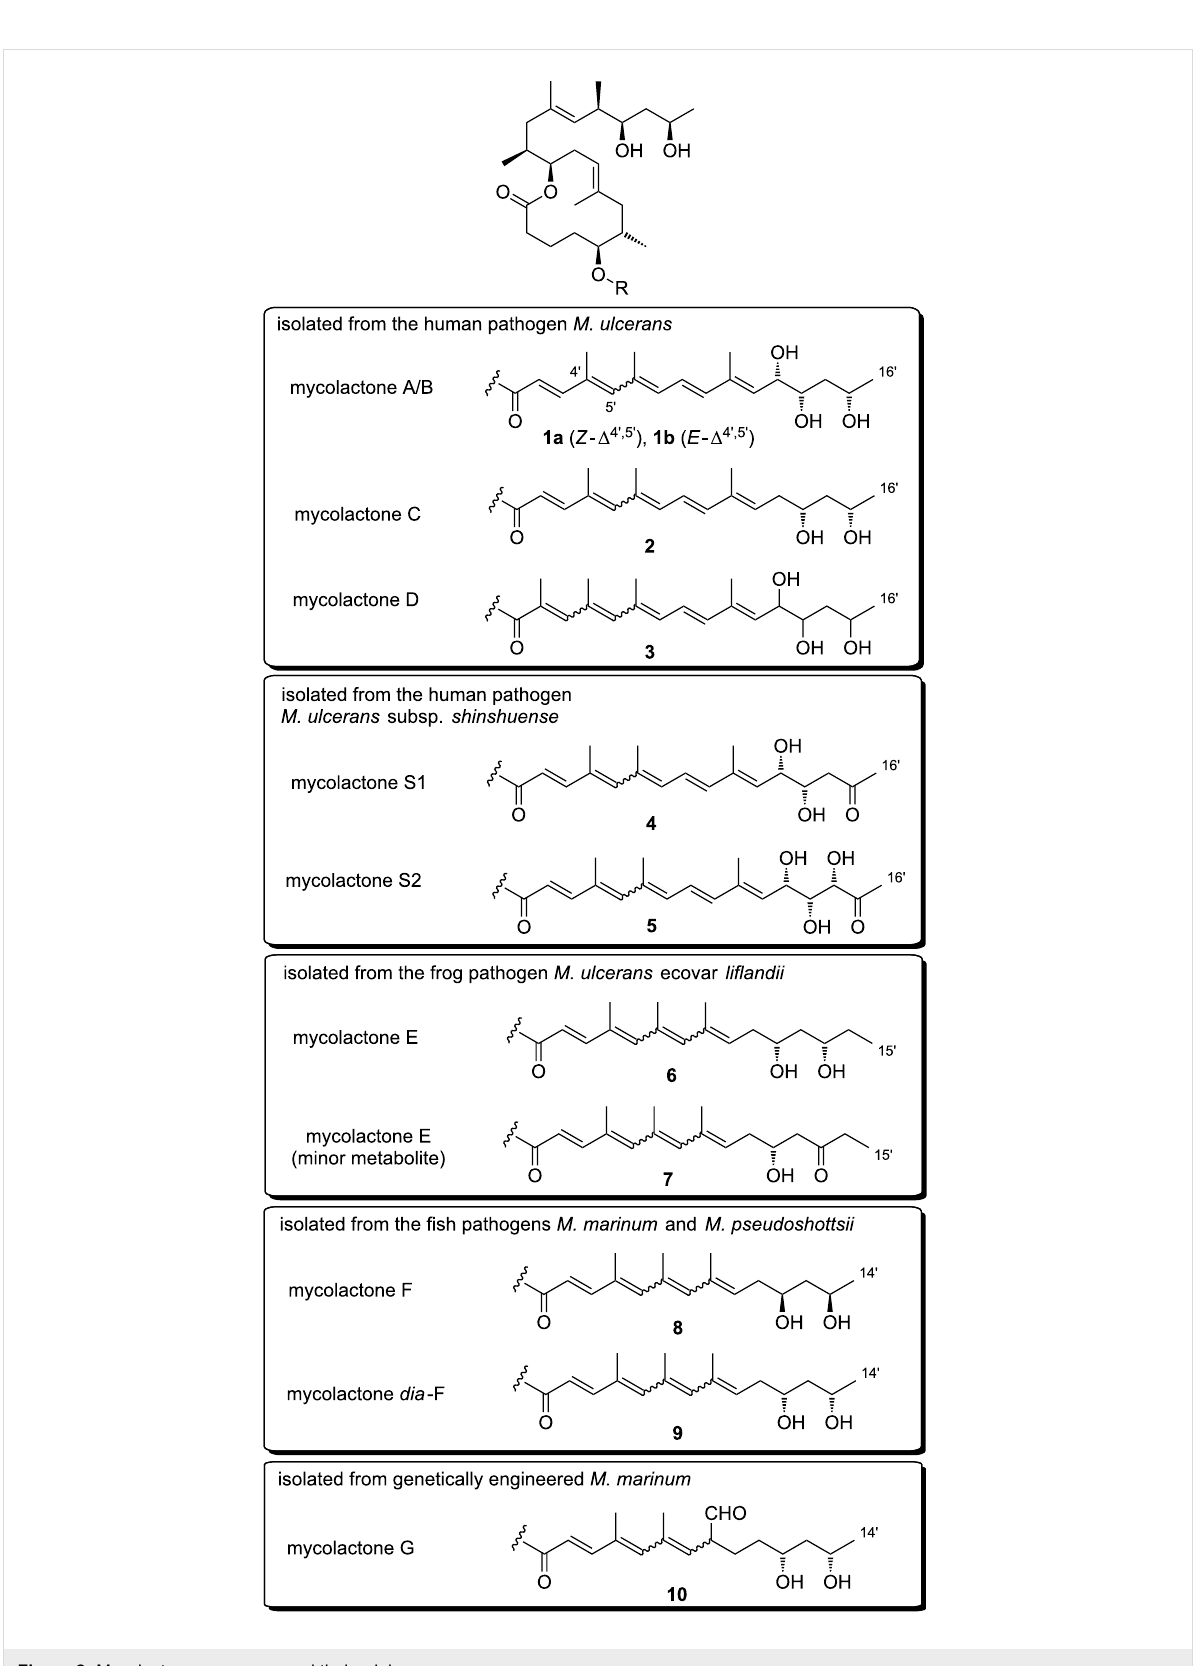
Figure 2: Mycolactone congeners and their